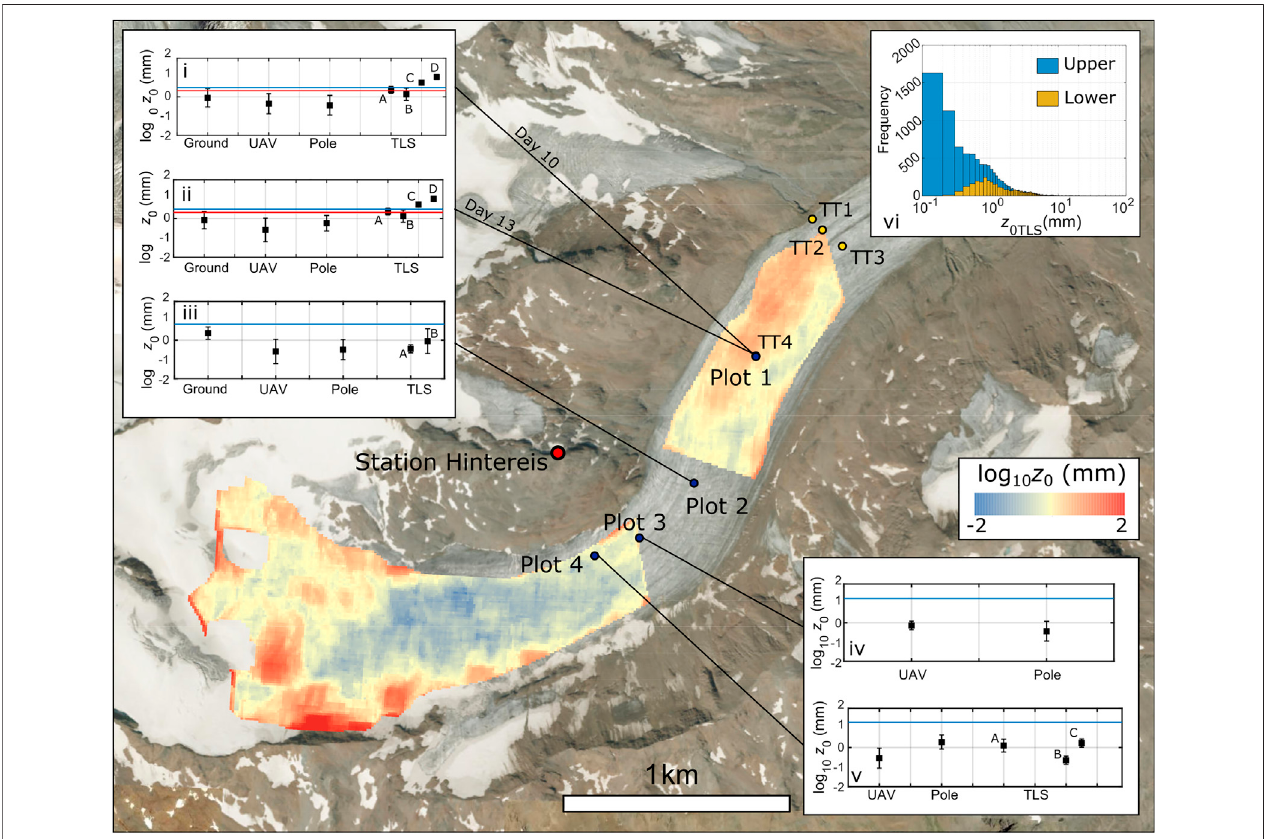
FIGURE5| Upscaledandcorrected z 0TLS .Datashownislog 10 transformed z 0TLS at10 mresolutionobtainedusing10 m × 10 mneighborhoods.Insetgraphs(i – v) show comparisons of z 0DEM from different sources. Ground, UAV and Pole data used 0.05 m resolution/0.5 m neighborhoods. TLS (A) used 5 m/50 m; TLS (B) 10 m/ 0TLS for the upper and lower glacier. The blue lines show z 0WT for each plot (see Table 4 ) and red lines show z 0EC at Plot 1.